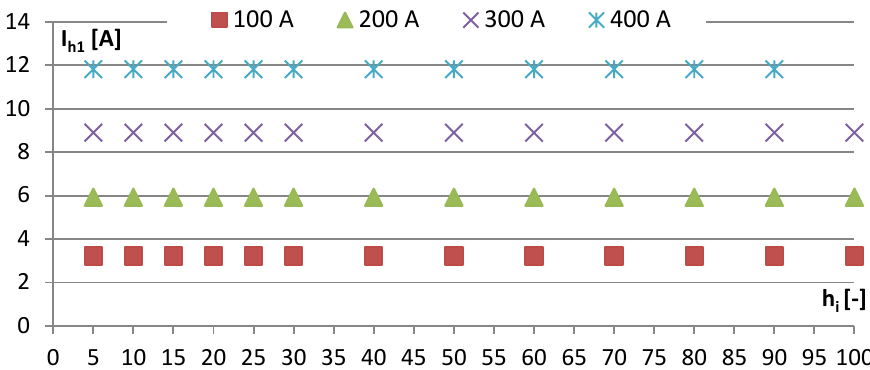
Figure 10. The frequency band of operation of the PWM-based power source for a required rms value of its main component of the output current.